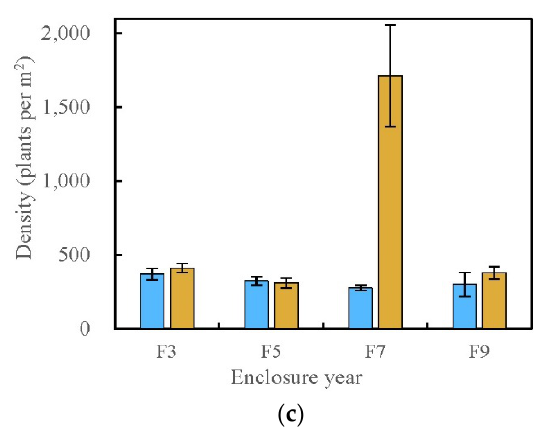
Figure 3. Variations in plant community characteristics observed both inside and outside the fenced enclosure in the third, fifth, seventh, and ninth years of the enclosure. Observed community characteristics include ( a ) species height in centimeters, ( b ) species’ relative ground coverage in percentage, and ( c ) plant density in terms of count of plant individuals per square meter.